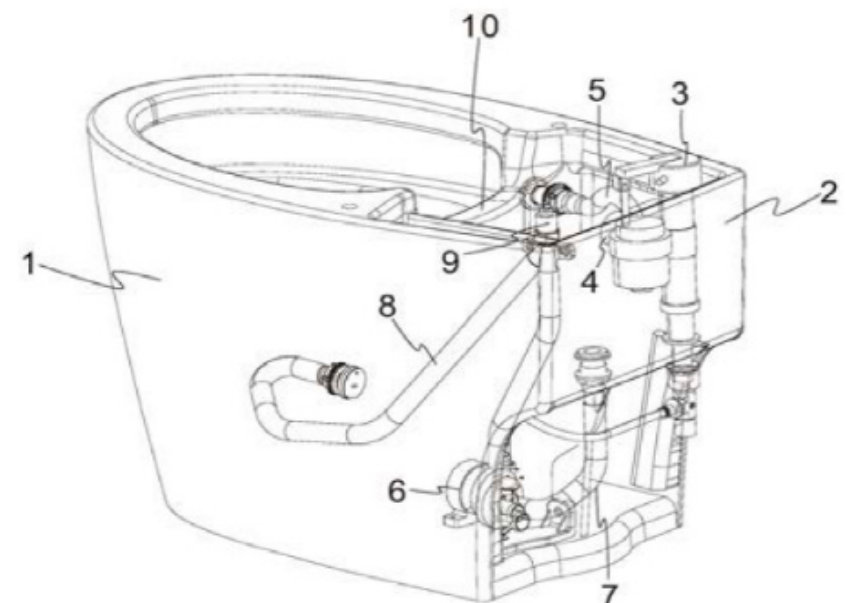
Figure 7. Schematic diagram of the R&D process of smart water closet. Note: 1—Toilet body; 2—Water tank; 3—Water inlet valve; 4—Swipe circle pump; 5—Arch bridge-shaped bend; 6—Jet pump; 7—Jet inlet pipe; 8—Injection water pipe; 9—Air isolation valve; 10- Overflow hole.